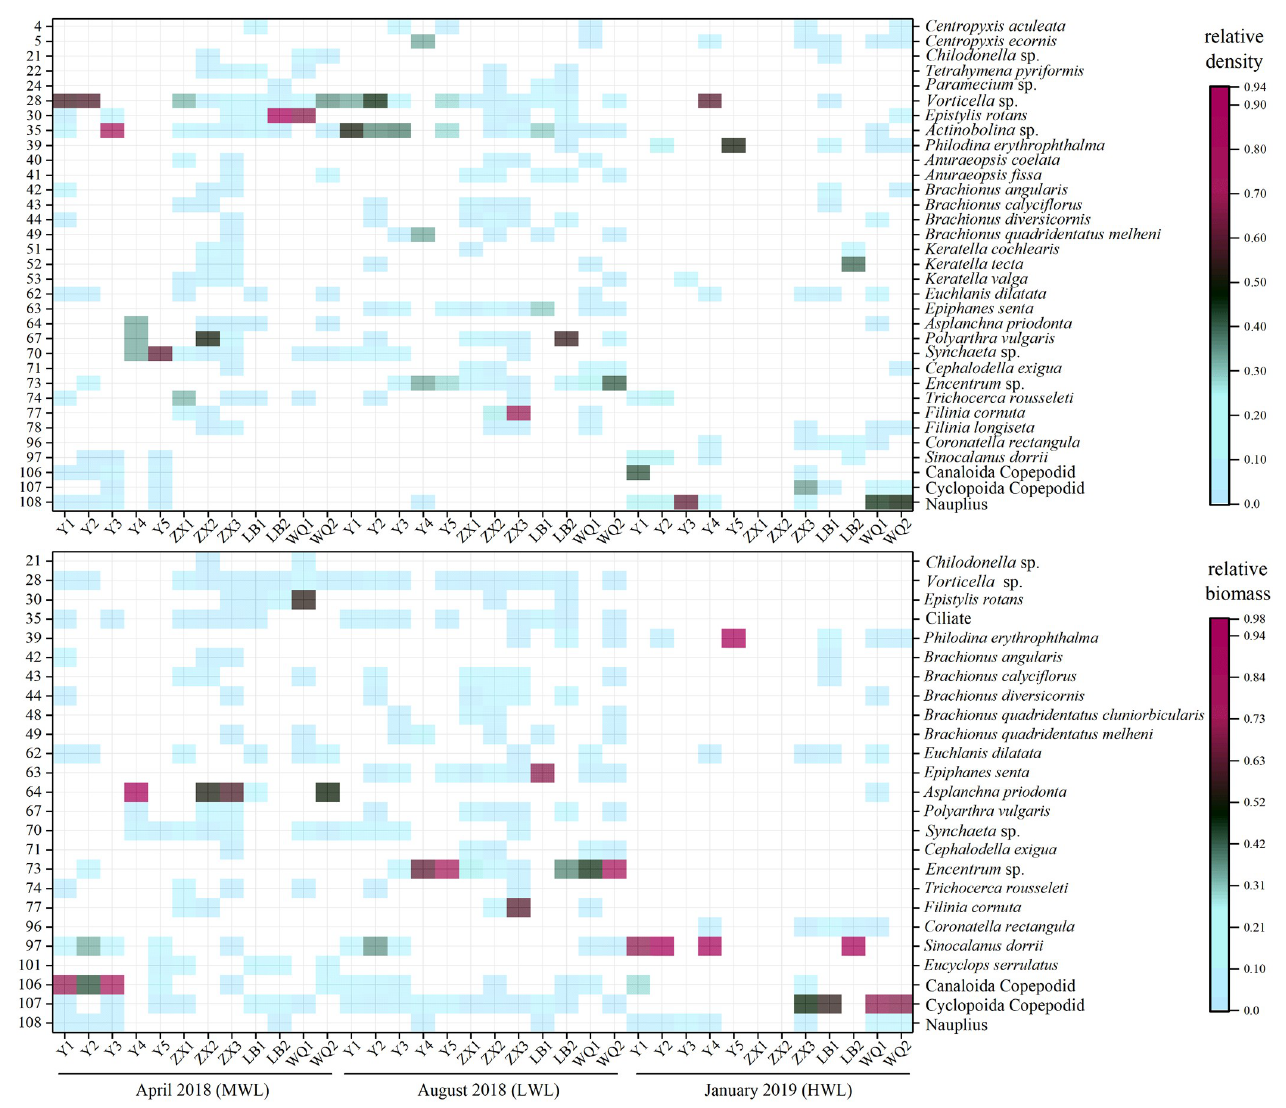
Fig 3. Heatmap of zooplanktons species among the all samples. The data was based on the relative density (above) and the relative biomass (below). Only showed those species with maximum proportion > 5% and frequency � 5 in all samples. The number on the Y axis was corresponding to that in S1 Table.